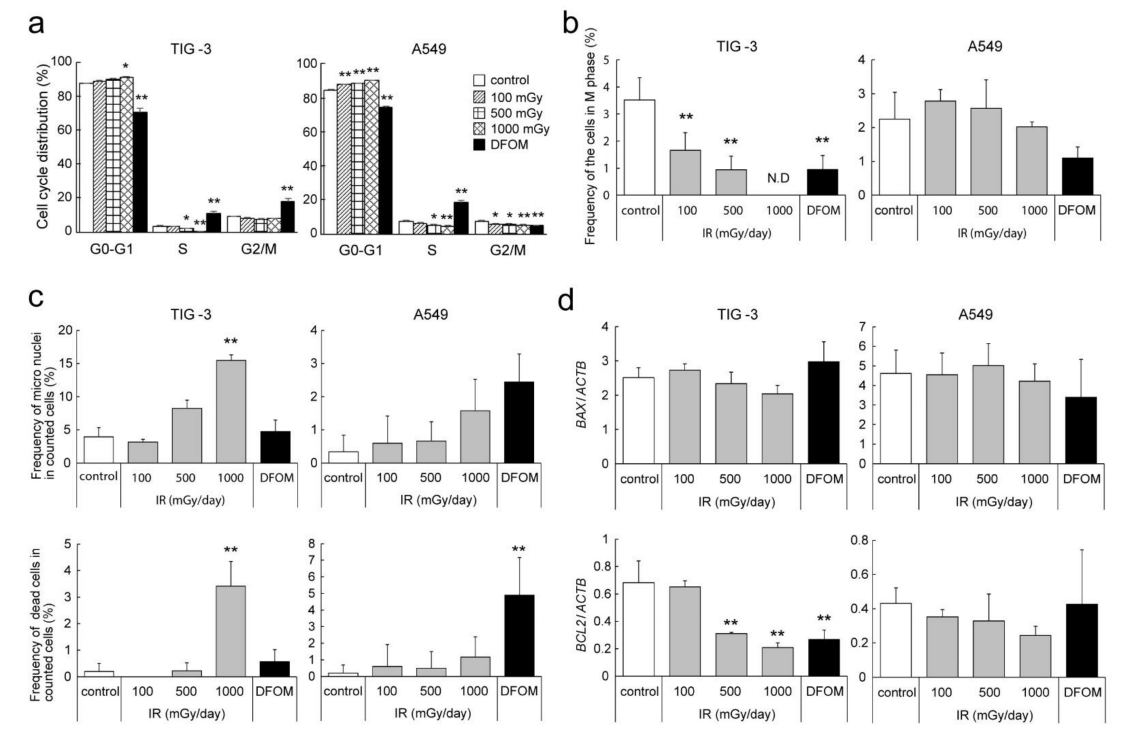
Figure 5. Effects of LDR-IR on cell cycle distribution and nuclear morphology. ( a ) Flow cytometry analysis was performed for evaluating the cell cycle in LDR-irradiated or DFOM-treated TIG-3 and A549 cells. ( b , c ) Microscopic observation was performed with DAPI nuclear staining. Frequencies of M phase cells ( b ), and micronuclei and dead cells ( c ). ( d ) Expression of BAX and BCL2 was analyzed via quantitative RT-PCR. Relative expression level was calculated as the ratio to ACTB levels. ( a – c ) Values are means and SD ( n = 3). * p < 0.05 vs. control; ** p < 0.01 vs. control.